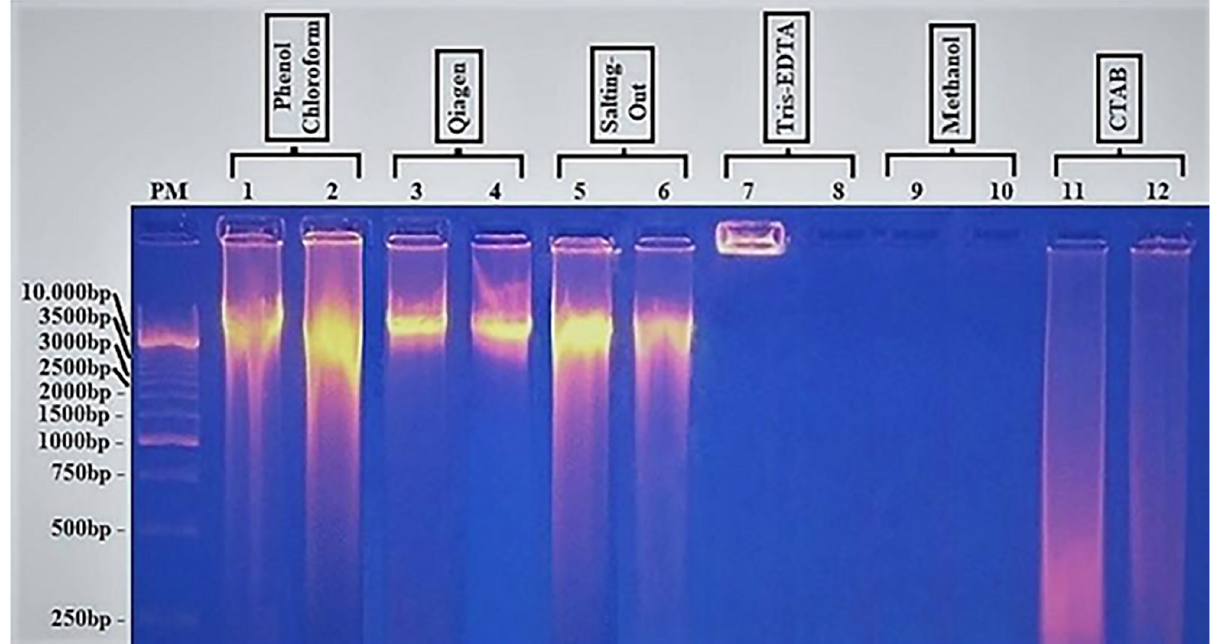
Fig 1. Comparison of six methods of Loa loa DNA extraction. Extracted DNA in duplicate was analyzed by electrophoresis in a 0.8% agarose gel and visualized under UV light. PM = standard molecular weight. Lines 1–2: DNA from phenol/chloroform; 3–4: Qiagen extract; 5–6: Salting-out extract; 7–8: Tris-EDTA extract; 9–10: Methanol extract; 11–12: CTAB extract. The values on the left are the size of